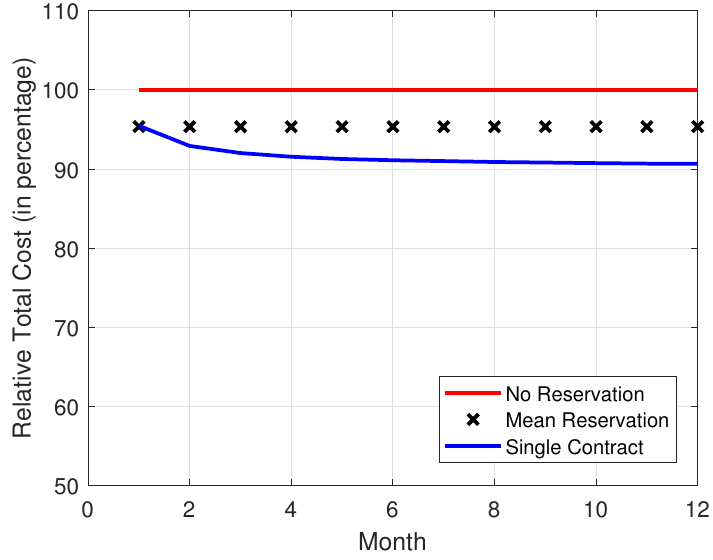
Figure 11. Relative total cost vs. month. The demand traffic is modeled as a Poisson stochastic process with mean = 4,000 VMs. Monthly cost (in